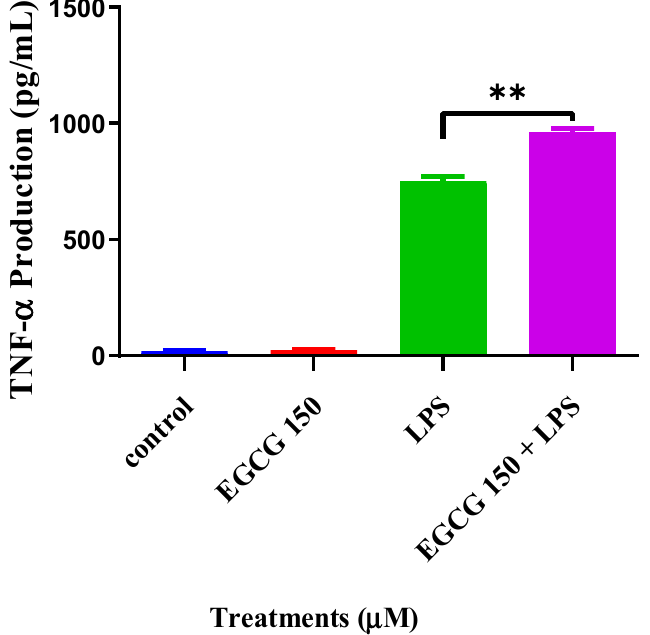
Figure 4. EGCG concentrations at 150 µ M coupled with 1 µ g/mL LPS increase TNF- α . Individual ELISA analysis of BV-2 cells shows that EGCG at 150 µ M and LPS (1 µ g/mL) had a 2% increase of TNF- α compared to LPS (1 µ g/mL). LPS 1 µ g/mL increased TNF- α by 30%. EGCG 150 µ M alone showed no significant change and was similar to the control (untreated cells). Values represent the mean ± SD, ** p ≤ 0.01 vs.